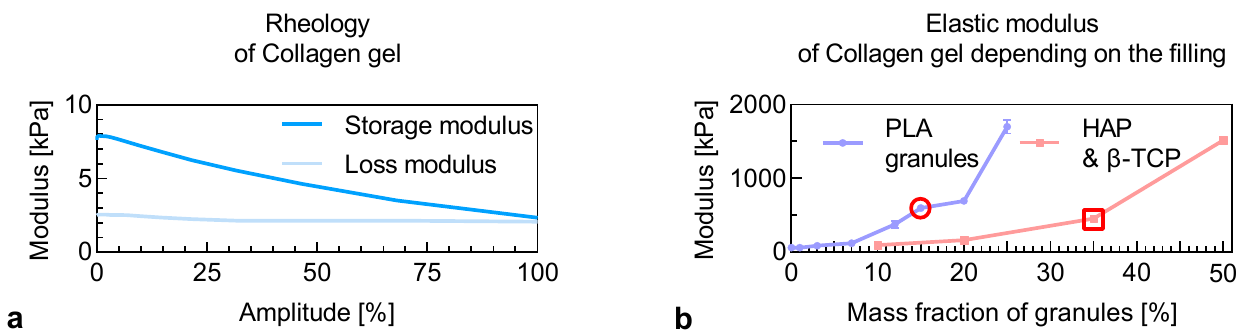
Figure 1. Rheological ( a ) and mechanical properties ( b ) of collagen-fibronectin hydrogel after curing and using various fillers.